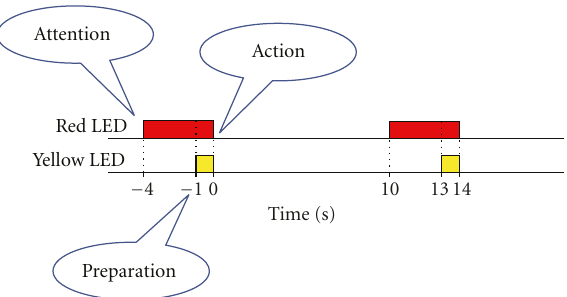
Figure 1: Event protocol. The red LED suggests attention, and the yellow LED suggests preparation for movement or preparation for movement imagination. Subjects are instructed to initiate the task when both LEDs are turned o ff ( t = 0